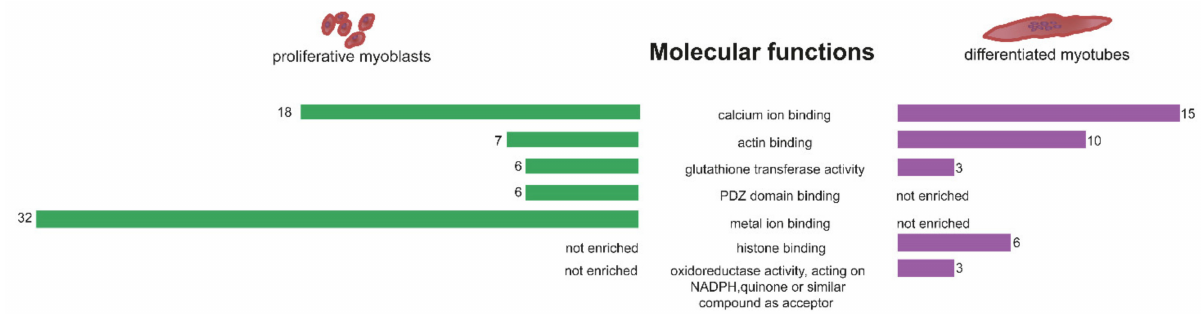
Figure 2. GO enrichment analysis for molecular function of genes differentially expressed between non-disease control and DM1. Significantly enriched molecular functions are shown for proliferating myoblasts ( left , green bars) and post-mitotic myotubes ( right , purple bars) with the number of genes in the respective molecular function displayed next to the